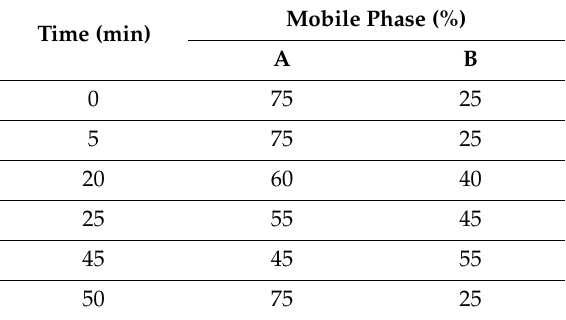
Table 1. Solvent gradient used for high-performance liquid chromatography (HPLC) analysis.